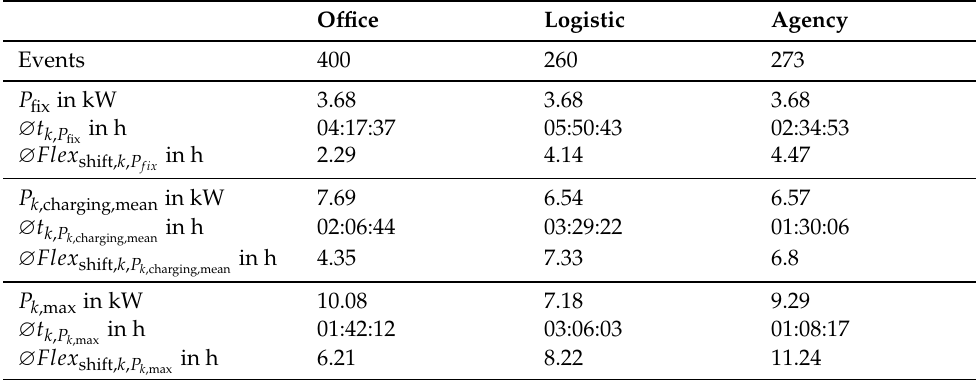
Table 3. Results of the analysis of the Time-Shift-Flexibility of sites at different charging